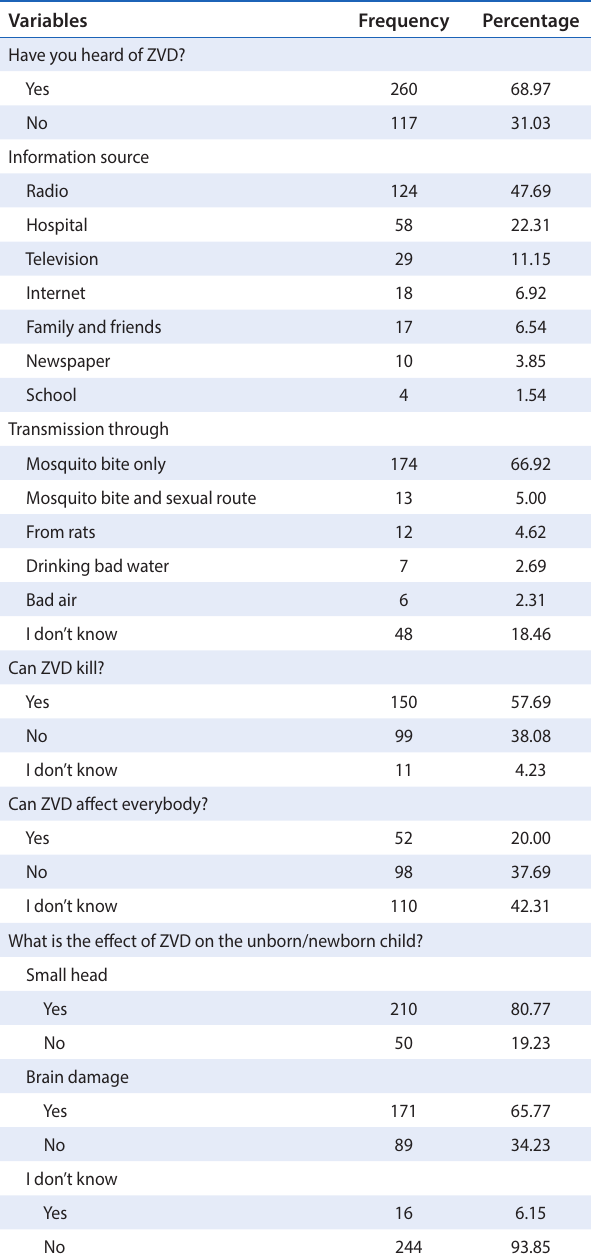
Table 2: Participants’ knowledge of ZVD and its reported complications ( n = 260) Variables